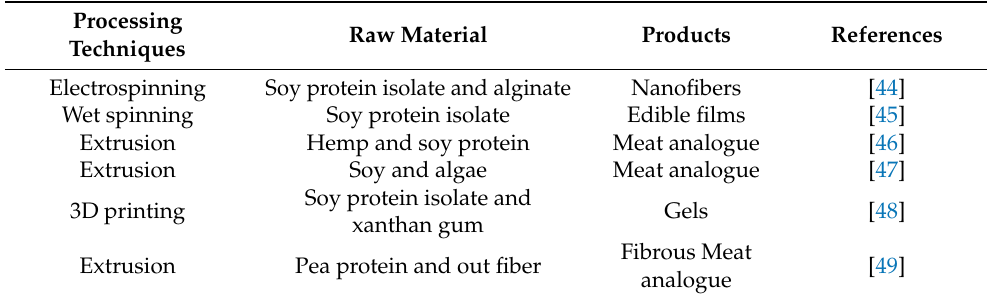
Table 3. A summary of processing techniques to obtain different plant protein-based products. Processing